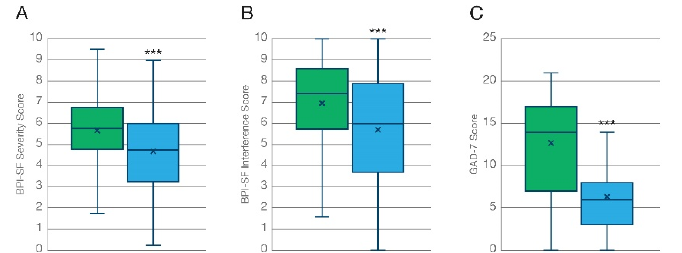
Figure 4. Improvement of indication-specific outcome measures at the 3-month follow-up. Analysis of PROMS shows how the inhalation of KHIRON 20/1 was associated with a marked improvement in self-reported ( A ) pain severity and ( B ) pain interference in patients diagnosed with chronic painful conditions, measured with the Brief Pain Inventory-short form (N = 174). ( C ) Generalized anxiety measured with the GAD-7 questionnaire was markedly decrease after 3 months of treatment with cannabis flos KHIRON 20/1 (N = 107). *** p < 0.001.